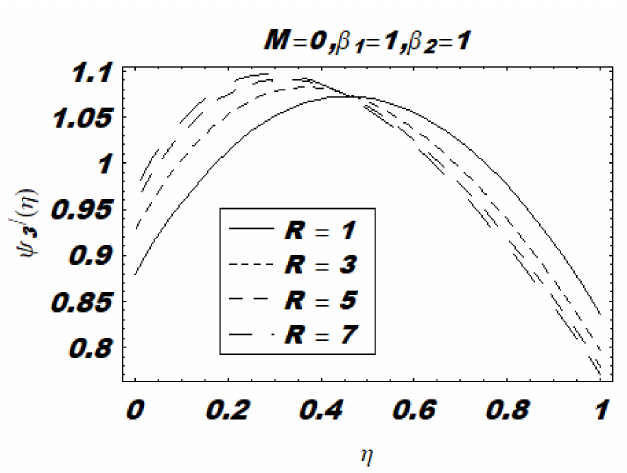
Figure 16. Similarity function ψ /